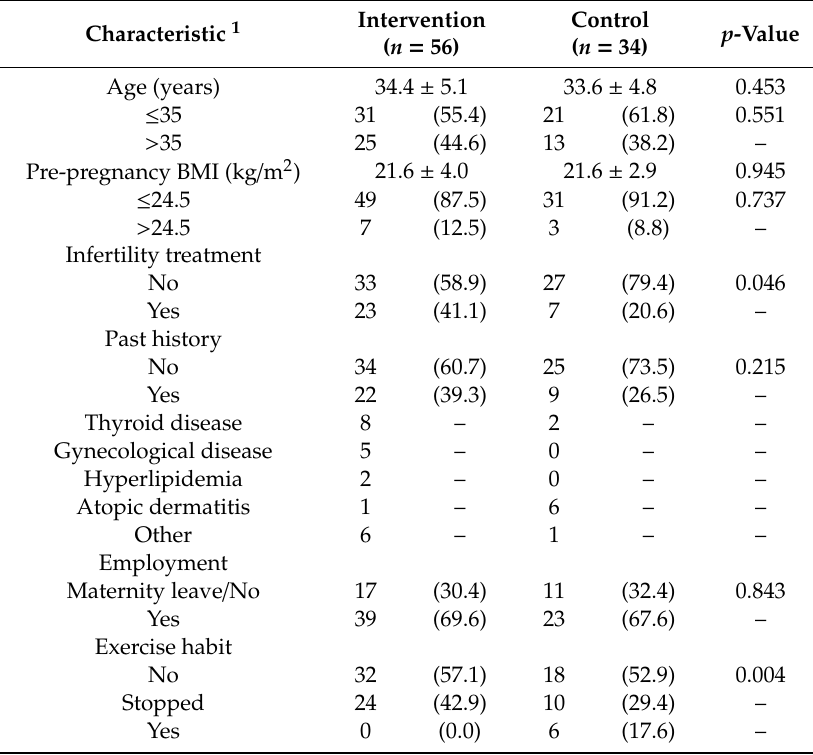
Table 1. Characteristics of the study